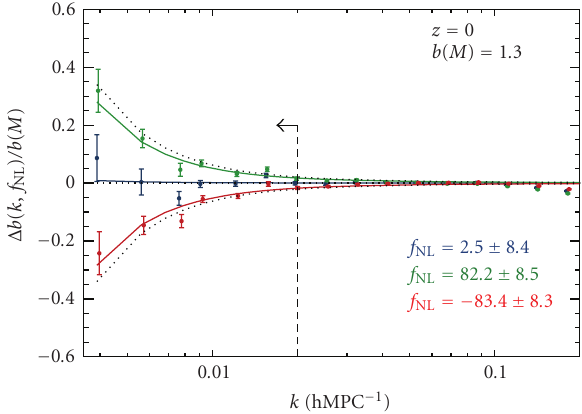
Figure 9: Fractional correction to the Gaussian halo bias in the f loc NL = ± 100 and Gaussian models. In contrast to Figure 8, halos were identified with a FOF finder of linking length b = 0 . 2. Only the wavemodes to the left of the vertical line were used to fit Δ b κ ( k , f loc For this low biased sample, the scale-independent correction is | Δ b | (cid:2) 0 . 003 and can thus be ignored. The best-fit value of f loc I and the corresponding 1 σ error is quoted for each model (Figure taken from